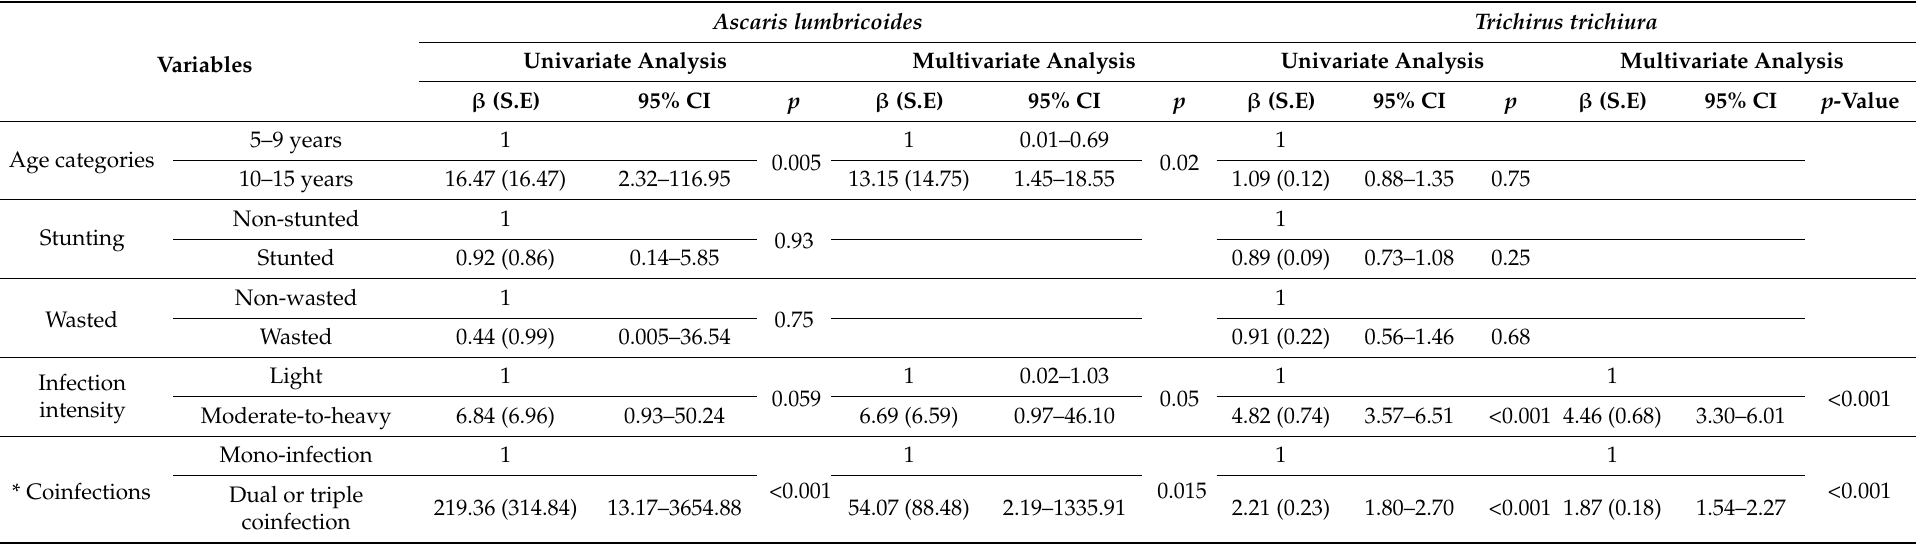
Table 6. Negative binomial regression model for factors associated with eggs count/gram of stool after